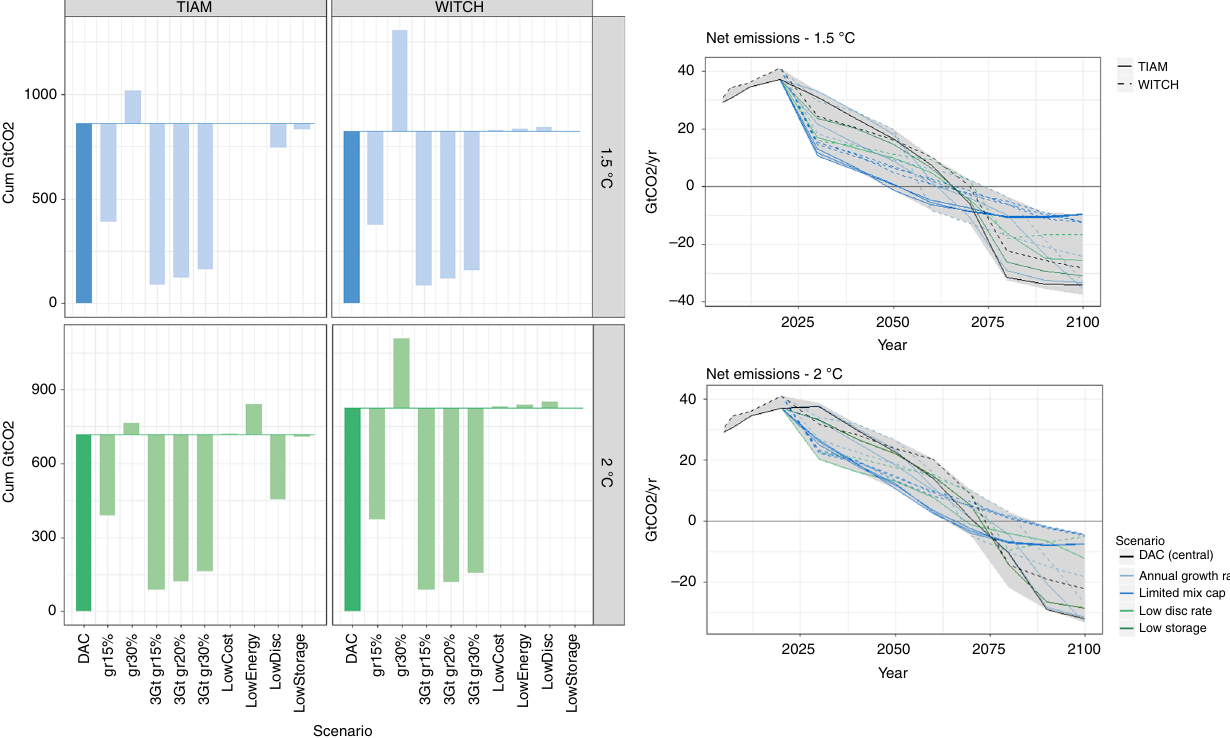
Variation in cumulative DACCS